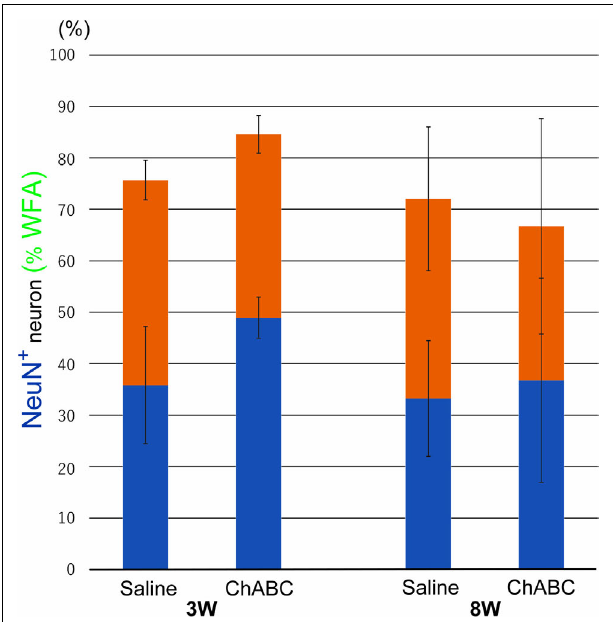
FIGURE 7 | Percentages of motoneurons whose cell bodies were covered with WFA -positive PNN structures among all motoneurons at 3 and 8 weeks after CST in rats with ChABC or saline administration. Blue bars indicate the percentage of motoneurons with > 80% WFA -positive structures, and red bars indicate the percentage of motoneurons with > 20% WFA -positive structures. Data are expressed as the mean ± SEM.